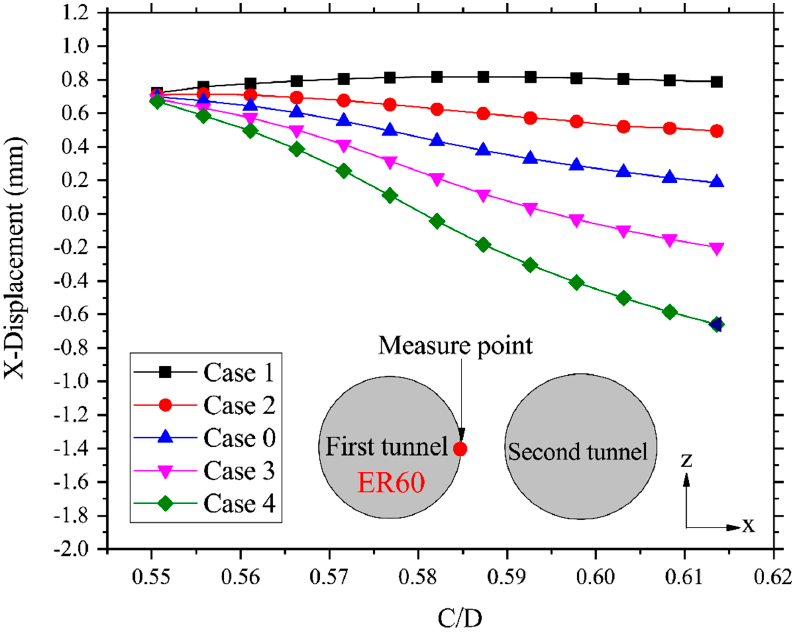
Figure 10. Lateral displacement of the lining under different grouting pressures.